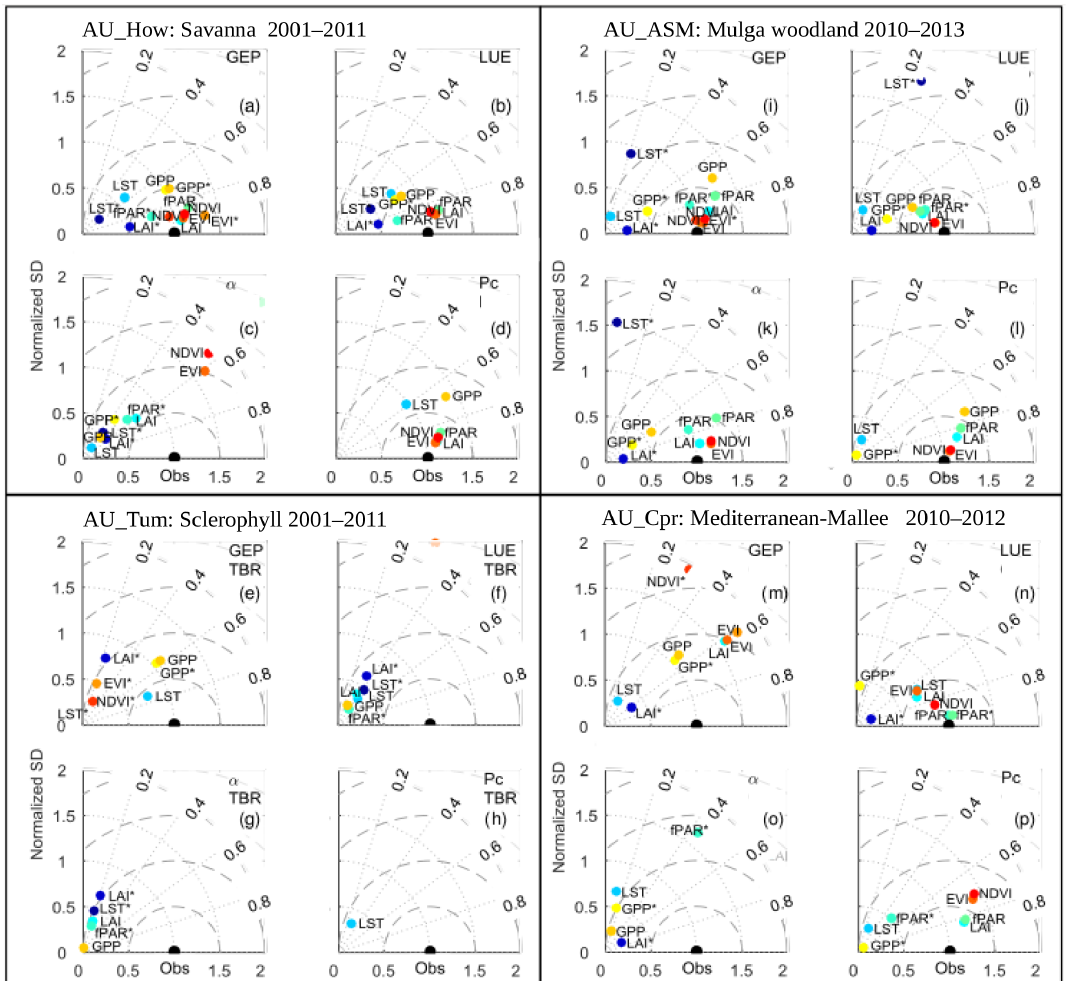
Figure 7. Taylor diagrams showing model results for Howard Springs (AU-How), Tumbarumba (AU-Tum), Alice Springs (AU-ASM), and Calperum–Chowilla (AU-Cpr) based on site-specific and all-sites linear regressions between gross ecosystem productivity (GEP), light use efficiency (LUE), photosynthetic capacity (Pc), and ecosystem quantum yield ( α) and different remote sensing products MODIS fixed solar zenith angle of 30 ◦ enhanced vegetation index (EVI) and normalized difference vegetation index (NDVI), gross primary productivity product (GPP), daytime land surface temperature (LST), leaf area index (LAI), and fraction of the absorbed photosynthetic active radiation (fPAR). All-site relationships are labelled with an asterisk (e.g. EVI ∗ ). EVI and NDVI labels are used instead of EVI SZA30 and NDVI SZA30 for displaying purposes. Missing sites indicate that the model overestimates the seasonality of observations – the model normalized standard deviation is